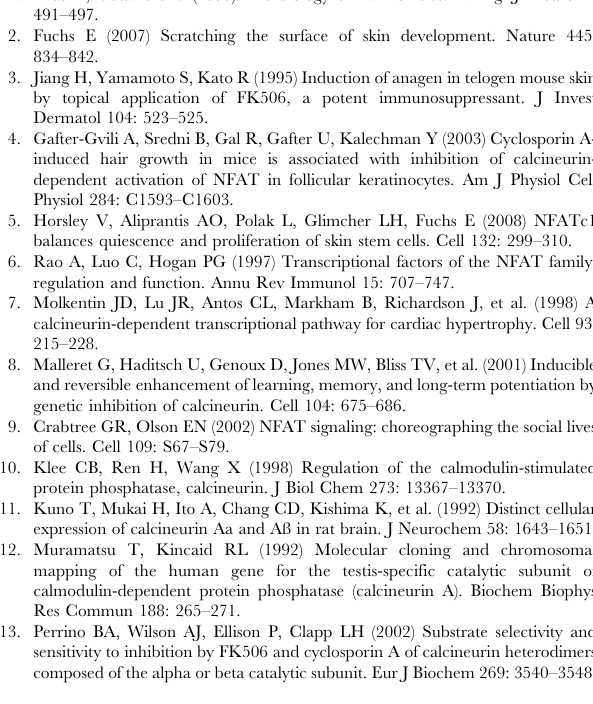
Figure S5 Distribution of CnAß-FK mRNA and NFATc2 in rat skin at postnatal days 24 and 25 (early phase of the anagen stage). (A–D) Distribution of CnAß-FK mRNA. (A and B), postnatal day 24 (P24); (C and D), postnatal day 25 (P25). (B and D) Sections were counter-stained with hematoxylin (blue). (E and F) Immunohistochemical analysis of NFATc2 in hair follicles at P24 and P25. In HG cells, NFATc2 was present in the cytoplasm. DP, dermal papillae; HG, hair germ; SG, sebaceous gland. Scale bars, 50 m m. Figure S6 Distribution of CnAß-FK mRNA in human skin. CnAß-FK is also expressed in human hair follicle.